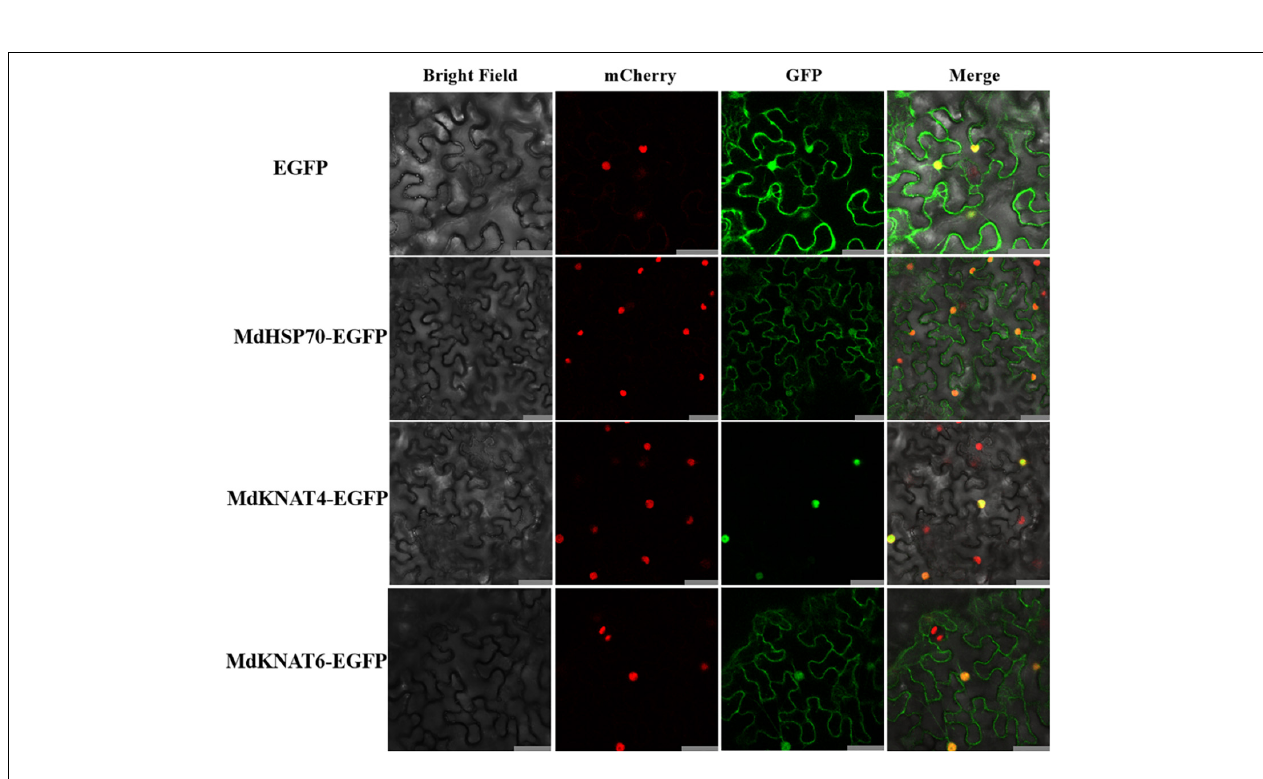
Frontiers in Plant Science |